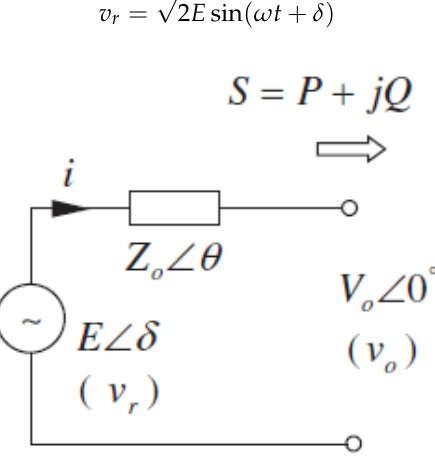
Figure 7. Simplified model of the three-phase four-leg inverter.